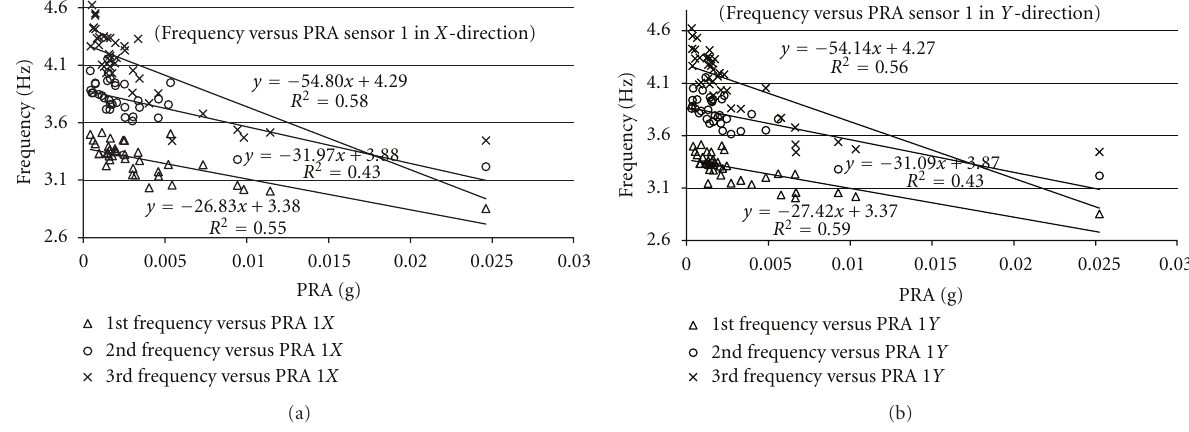
Figure 14: First three modal frequencies of building B for flexible base case versus PRA of sensor 1: (a) X -direction and (b) Y -direction.